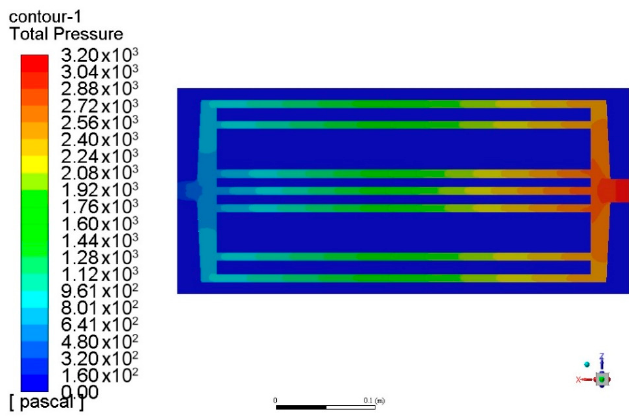
Figure 25. Temperature distribution on cooling plate with optimized geometry.